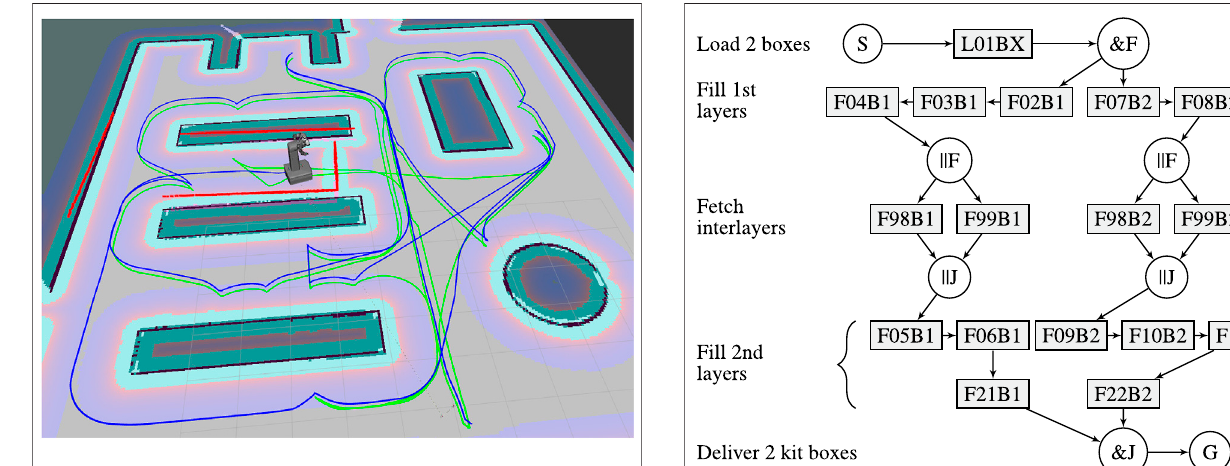
FIGURE3 | Warehouse layout. The lightgreen path, startingand ending at the bottom right, is the initial route for Scenario (B) . The robot has stopped in front of an obstacle that is blocking the initially planned movement. The red lines along the shelves, the wall and the obstacle indicate the objects perceived by the robot ’ s laser scanner. A replanned route in blue, starting at the robot ’ s location, has changed the order of the remaining tasks.